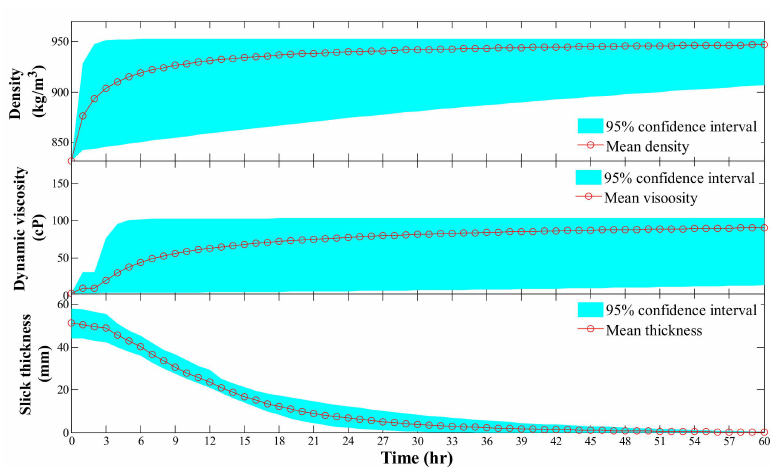
Figure 10. Simulation results of skimmer ORRn.